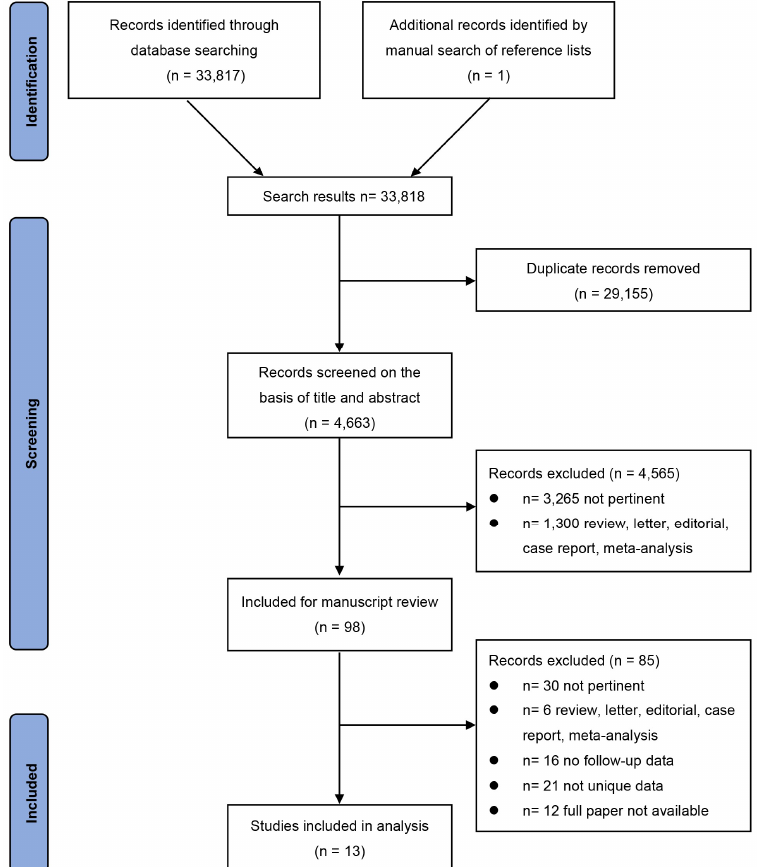
Figure 1. Flow chart of study selection.